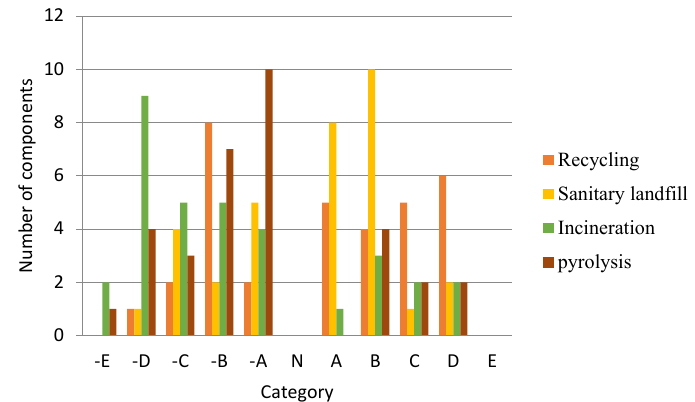
Fig. 6: Comparison of the scenarios assessed by the RIAM method